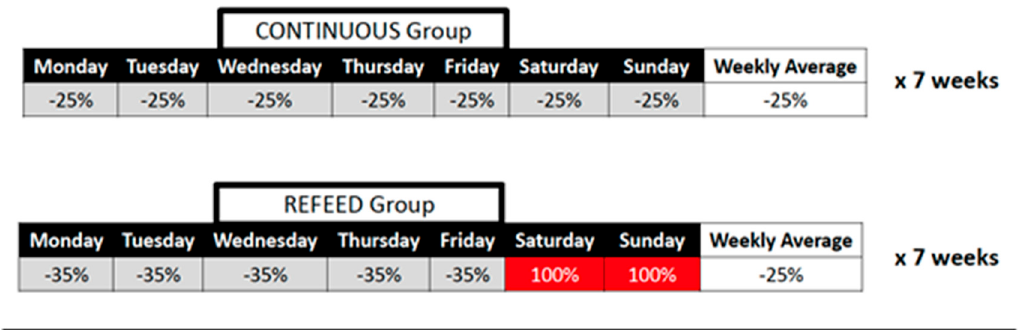
Figure 1. Caloric restriction during a typical week of dieting for both isocaloric diet treatments.